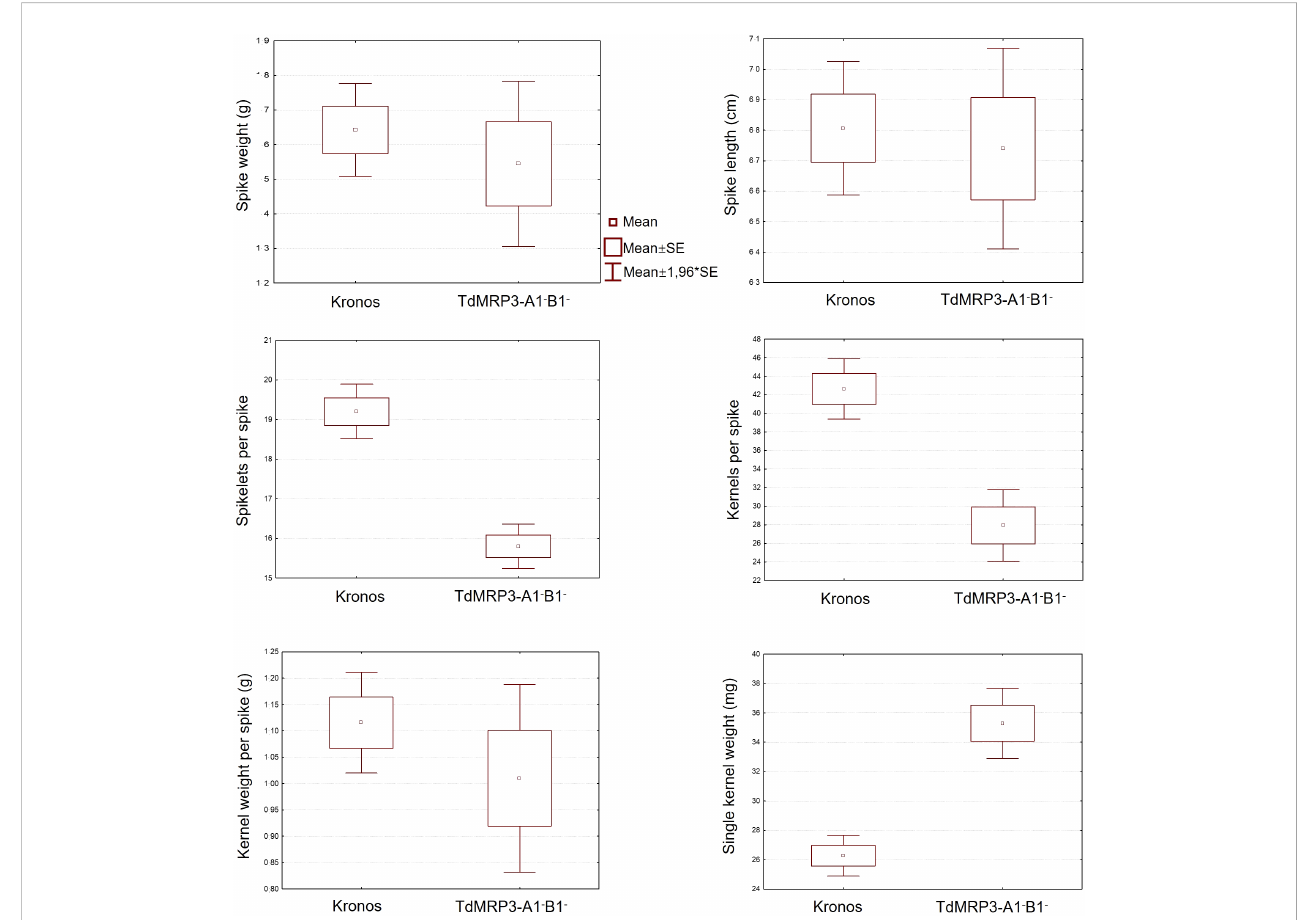
FIGURE 5 Agronomic traits analysis performed on: Spike weight (g), Spike length (cm), Spikelets per spike, Kernels per spike, Kernel weight per spike (g), Single kernel weight (mg). In each image there is the analysis of the seeds of cv. Kronos compared to TdMRP3-A1 - B1 -